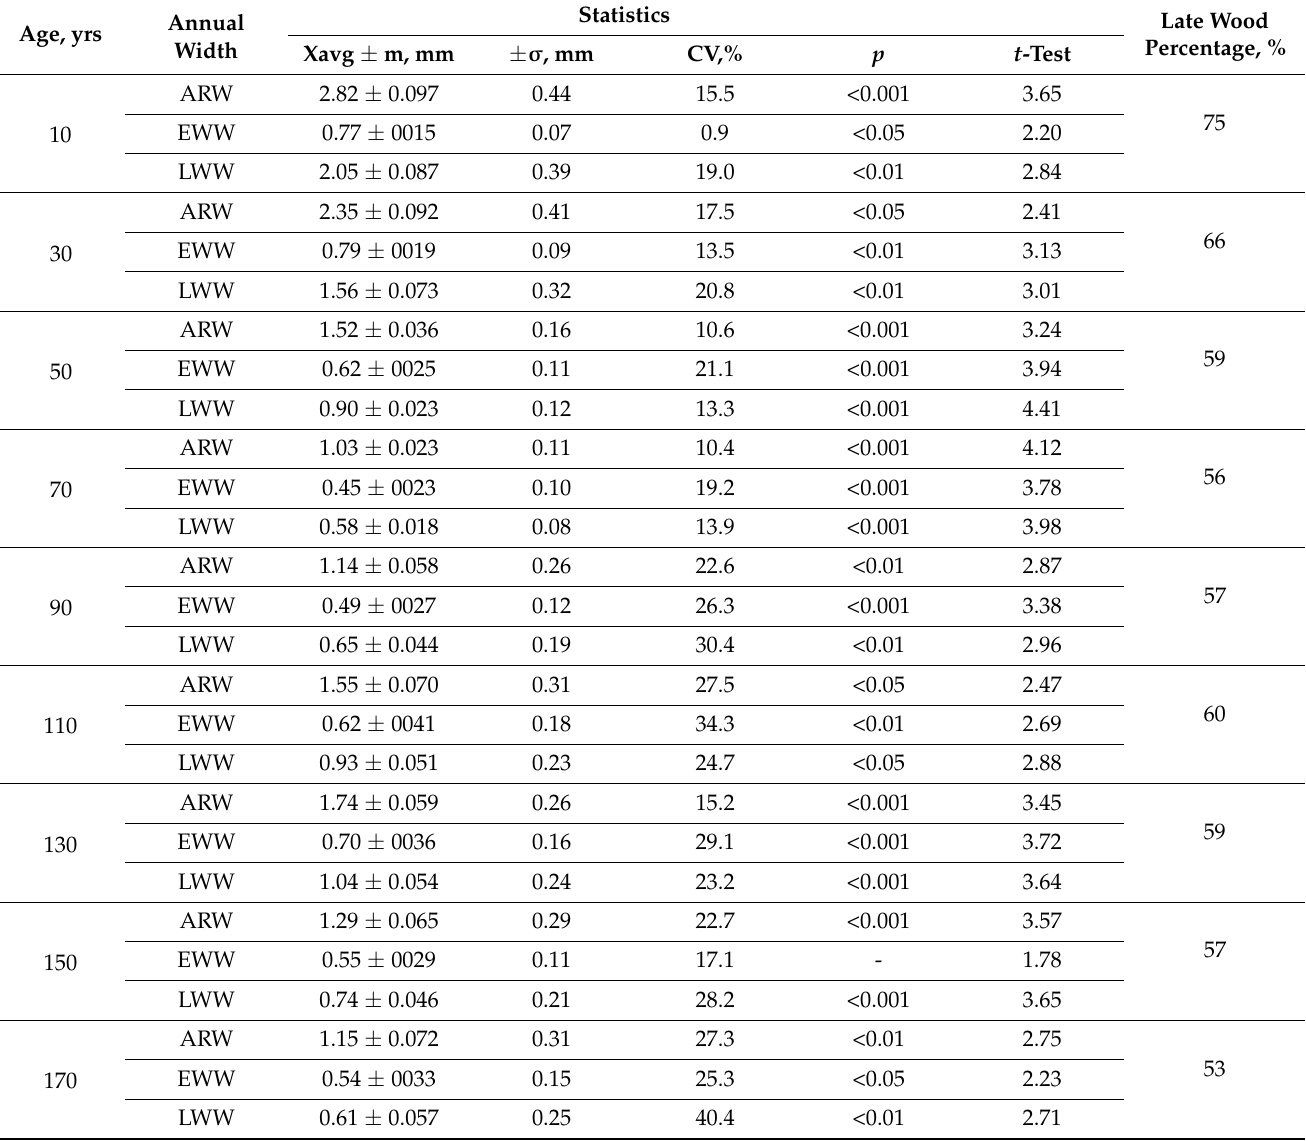
Table 2. Statistics on annual ring width and late wood width, by oak